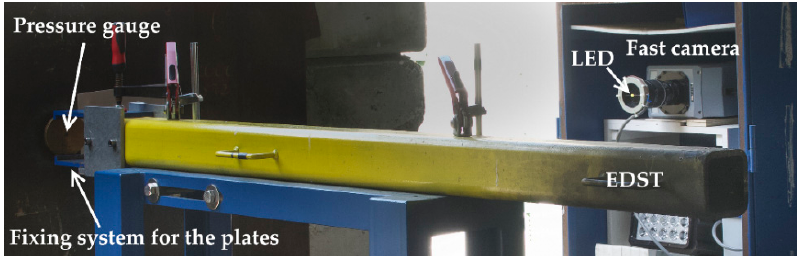
Figure 3. View of the experimental setup, showing the explosive driven shock tube and the high speed camera with the LED.